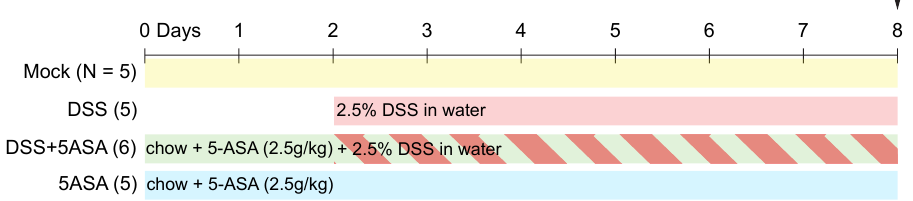
Figure 5. Experimental design. Mice were divided into four treatment groups: mock-treated (N = 5), DSS (N = 5) mice received 2.5% DSS in water for 6 days starting at the indicated time, DSS + 5-ASA (N = 6) mice received 2.5g/kg 5-ASA in chow for 8 days and 2.5% DSS in water for 6 days starting at the indicated time, and 5-ASA (N = 5) mice received just the chow with 2.5g/kg of 5-ASA during the duration of